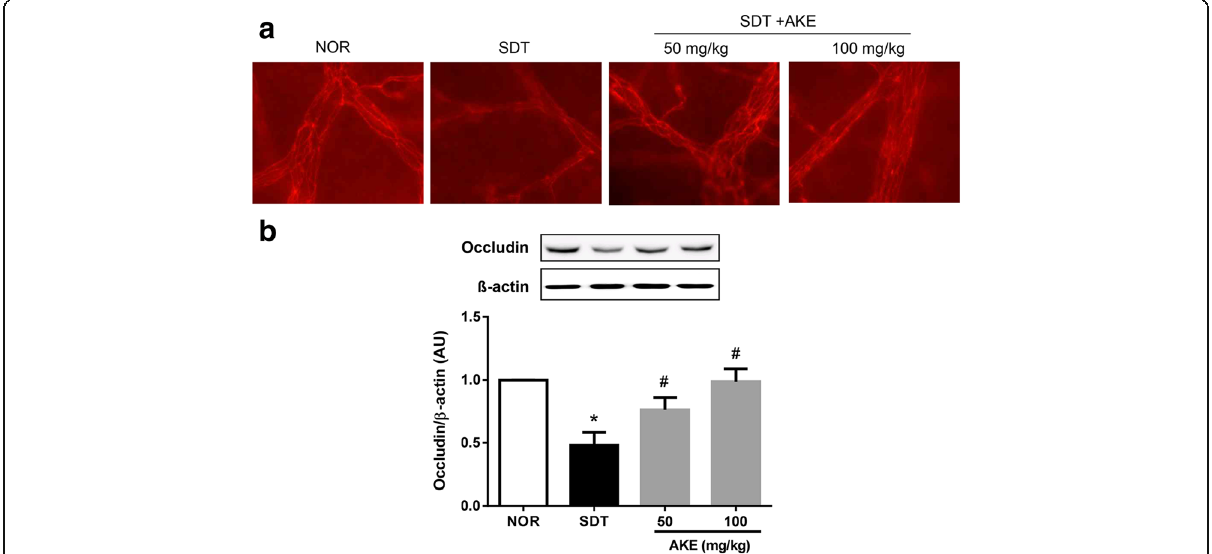
Fig. 2 Tight junction protein loss. a Immunofluorescence staining for occludin. b The total protein was isolated from retinal tissues, and a western blot was performed. Values in the bar graphs represent the mean ± SE, n = 5. * p < 0.05 vs. NOR, # P < 0.01 vs.